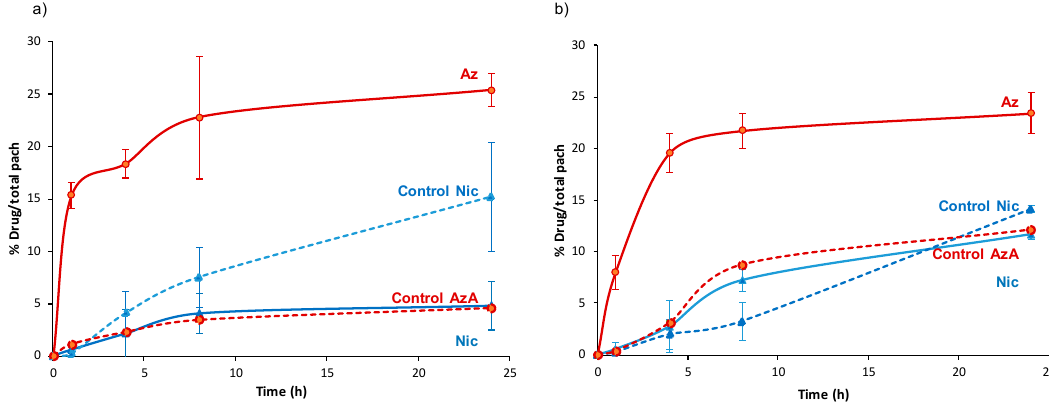
Figure 7. Nic and AzA delivery profile from ( a ) NicAzA@MIL-100_pach, and ( b ) NicAzA@MIL- 127_pach to the receptor compartment of the Franz chamber (diffused Nic and AzA).